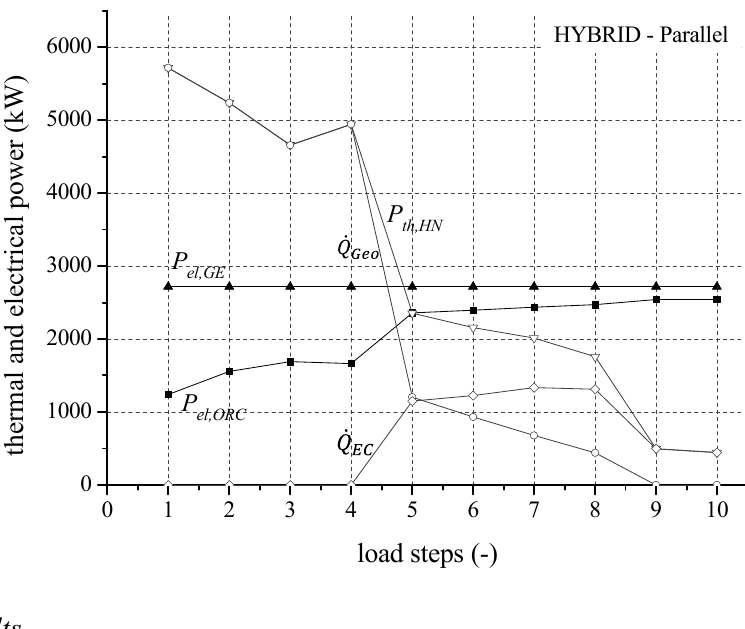
Figure 10. Electrical and thermal power of the power plant units for a maximum supply temperature of the heating network of 130